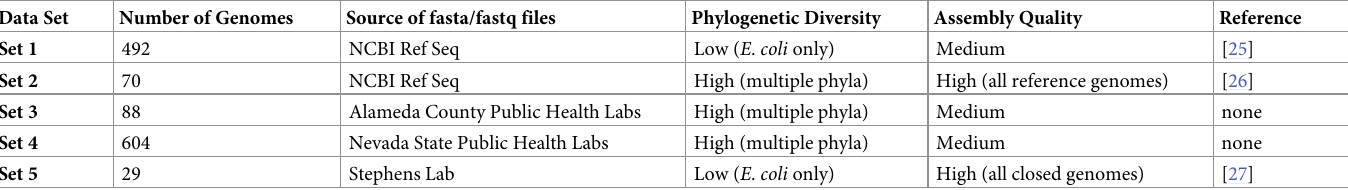
Table 1. List of genome sets used in this